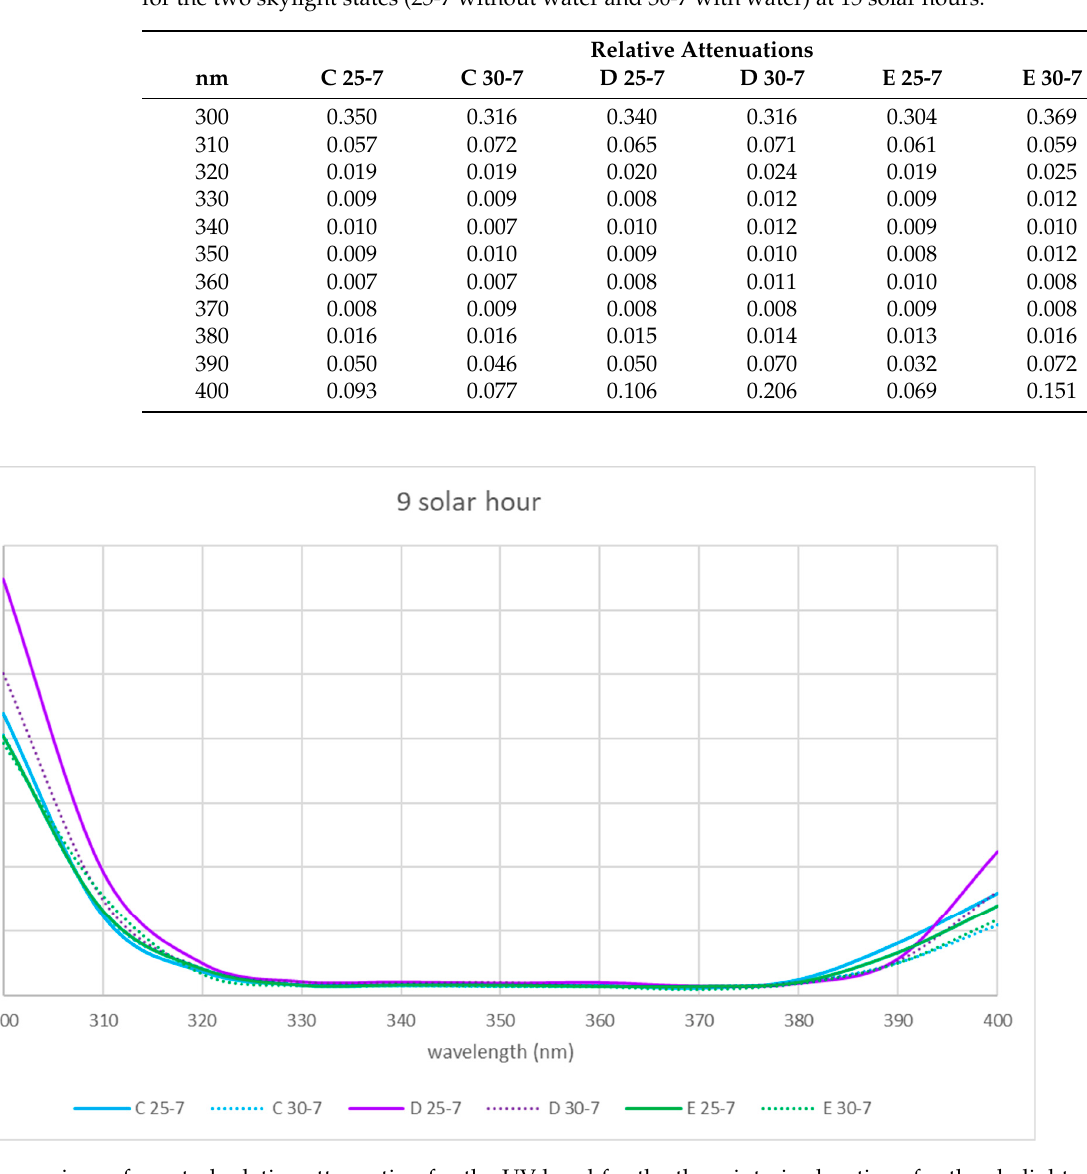
Figure 15. Comparison of spectral relative attenuation for the UV band for the three interior locations for the skylight without (25-7) and with water (30-7) at 9 a.m. solar time.